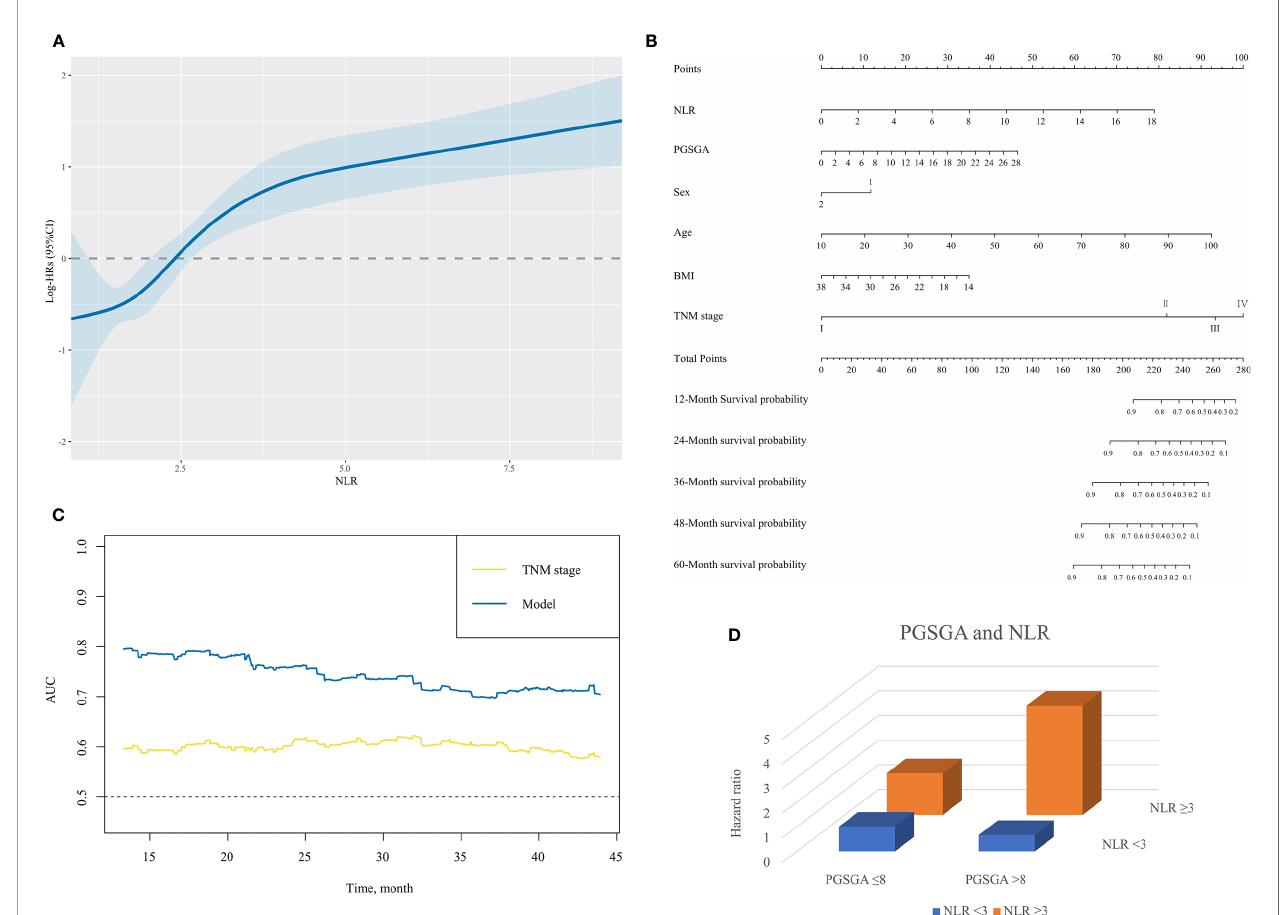
FIGURE 3 | (A) The association between NLR (continuous) and hazard ratio of overall survival for patients with NPC undergoing chemoradiotherapy. Splines are adjusted by sex, age, body mass index, alcohol consumption, TNM stage and PG-SGA. (B) The nomogram for predicting the 12- to 60-month overall survival time of patients with NPC undergoing chemoradiotherapy. In the nomogram, an individual patient ’ s value is located on each variable axis. Based on the number of points received for each corresponding value, the sum of these numbers is located on the total point axis to determine the likelihood of 12- to 60-month survival in the matched survival axes. (C) A summary chart merged the AUC for prediction of survival at 12, 24, 36, or 48 months by nomogram (model) and TNM stage. The predictive capacity of model had a signi fi cant improvement as compared with TNM stage. (D) The interactive association of NLR and PG-SGA for patients with NPC undergoing chemoradiotherapy, presented by three-dimensional bar diagram. NLR, neutrophil-to-lymphocyte ratio; NPC, nasopharyngeal carcinoma; PG-SGA, Patient-Generated Subjective Global Assessment; AUC, area under the receiver operating characteristic